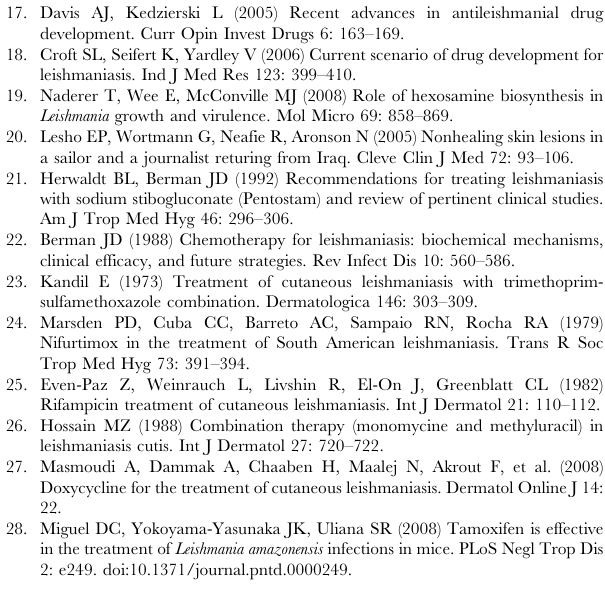
Figure S1 L. major promastigote growth curve exhibits charac- teristic exponential, stationary and decline phases. To develop and validate our HTS assay, we defined the growth characteristics of the L. major promastigote. Promastigotes were seeded at 105 parasites per mL on day 0 and the number of parasite determined for seven days. (1) Exponential growth phase; (2) Stationary growth phase; and (3) Decline. (n= 2, bars =range). Figure S2 HTS statistics from the primary screen. Z-factors and signal to back grounds for all 618 primary screening assay plates. Table S1 Confirmed leishmanicidal compounds as identified from the L. major HTS assay using the PMLSC library. ADMET - Adsorption, distribution, metabolism, excretion and toxicity; Ames - Ames test; hERG inhibition; RI - Reliability Index of in silico predicted data; SI - Skin irritation; OB - Oral bioavailability; LD50 - half maximal lethal dose; IP - intraperitoneal, OR - Oral, IV - intravenous, or SC - Subcutaneous administration; Tanimoto similarity score - method of calculating the similarity between chemical structures, SSG - sodium stibogluconate and AB - amphotericin B; AID - Assay